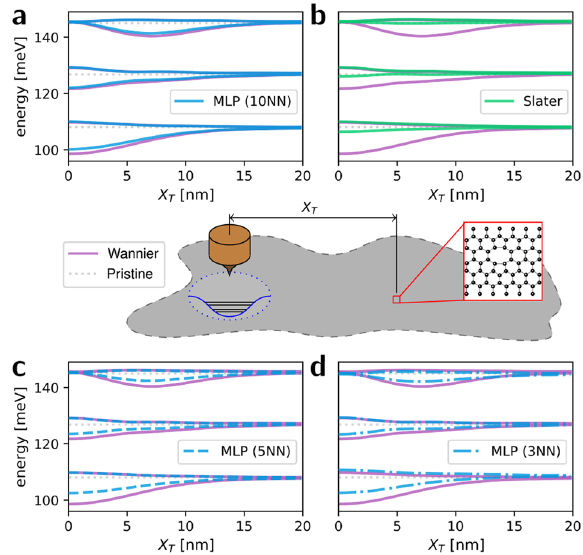
Fig. 8 Quantum dot benchmark of vacancy defect. Level spectrum landscapes calculated with different TB parametrizations of the double vacancy in SLG compared against the Wannier parametriza- tion [ a MLP(10NN), b Slater – Koster, c MLP(5NN), d MLP(3NN)]. Inset shows schematic sketch of the underlying system: we calculate the level spectrum (orbital and valley quantum number, spin is omitted) as a function of the position of an STM-tip (brown) induced (smoothly con fi ned) GQD relative to an embedded defect in a large graphene fl ake (gray rectangle). Dotted gray lines represent the level structure of a pristine GQD with doubly degenerate